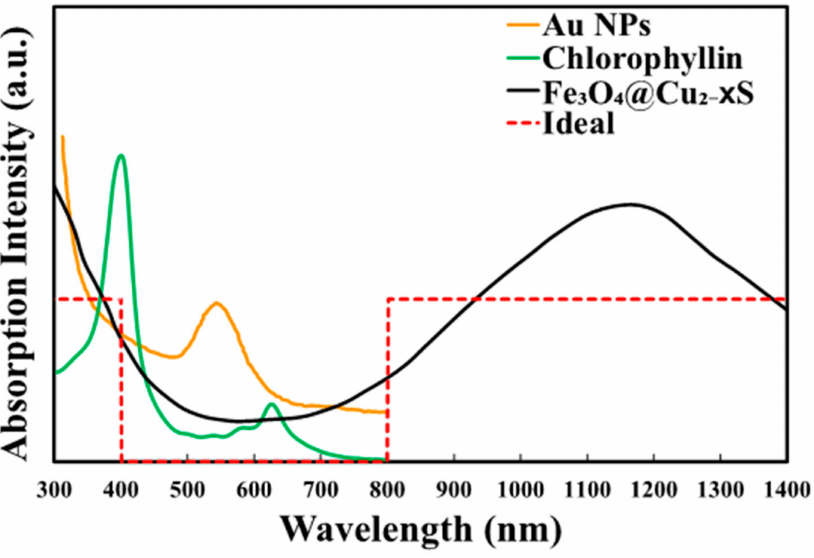
Figure 2. Optical absorption spectra of different materials as